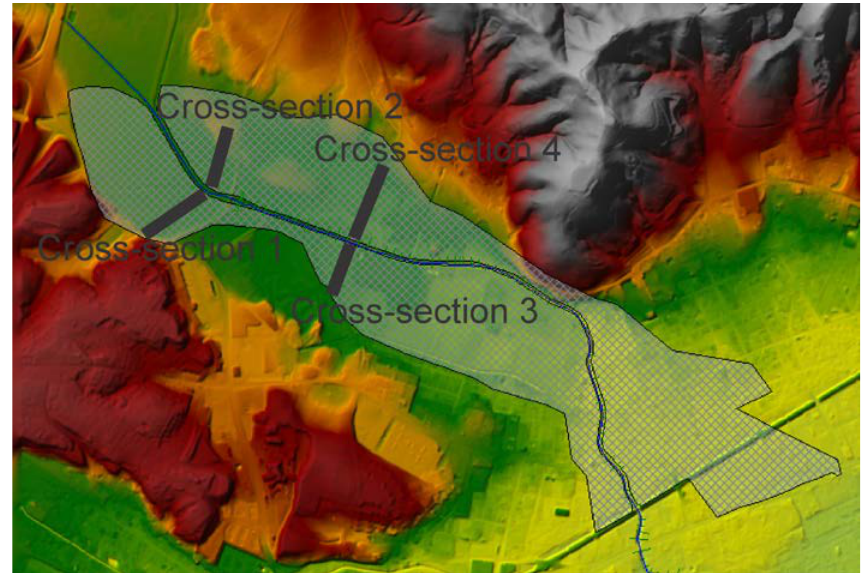
Figure 3. Selected cross-sections (1–4) on the floodplain areas that were used to compare volumes flowing on the floodplains, maximum water velocities on the floodplains, and maximum water depths.